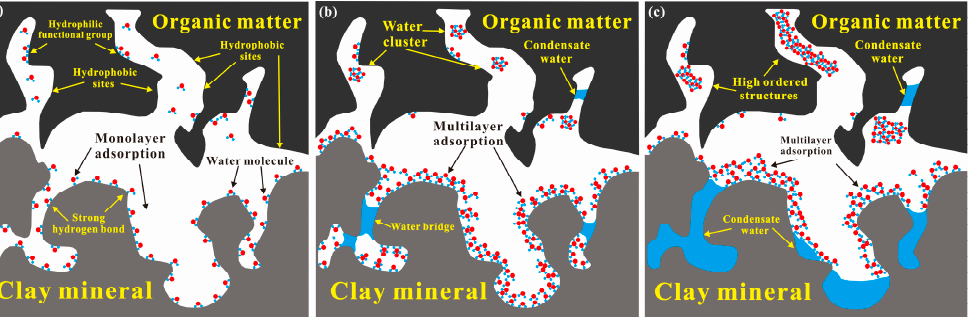
Figure 2. Occurrence and distribution characteristics of water in shale under different moisture con- tent conditions. ( a ) Low moisture content. ( b ) Moderate moisture content. ( c ) High moisture content. These figures are modified from Han et al. (2021) [96].